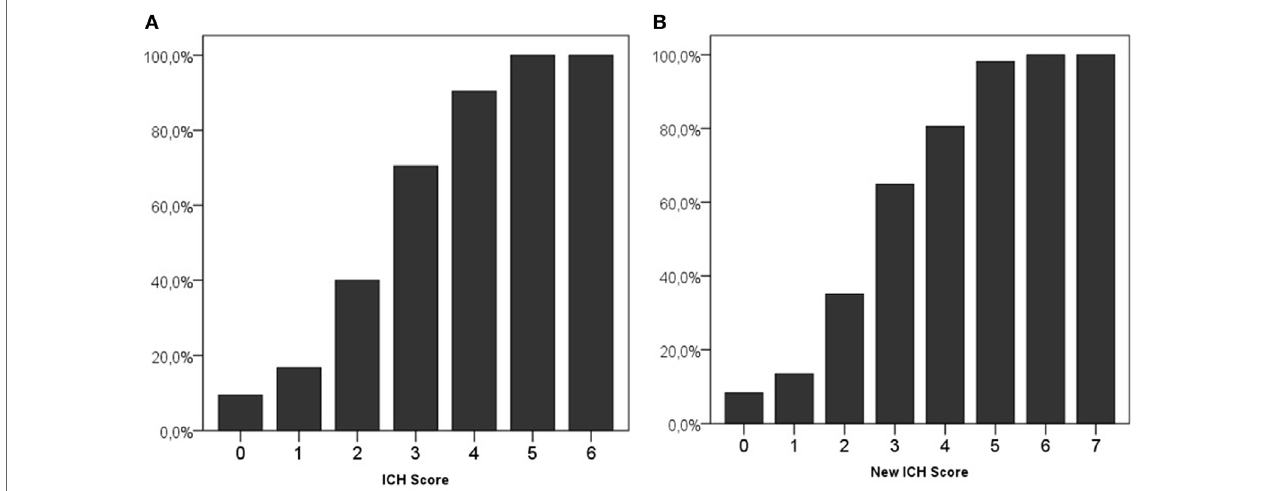
FigUre 1 | 30-Day mortality on different scores of the intracerebral hemorrhage (ICH) score (a) and new ICH score (B)